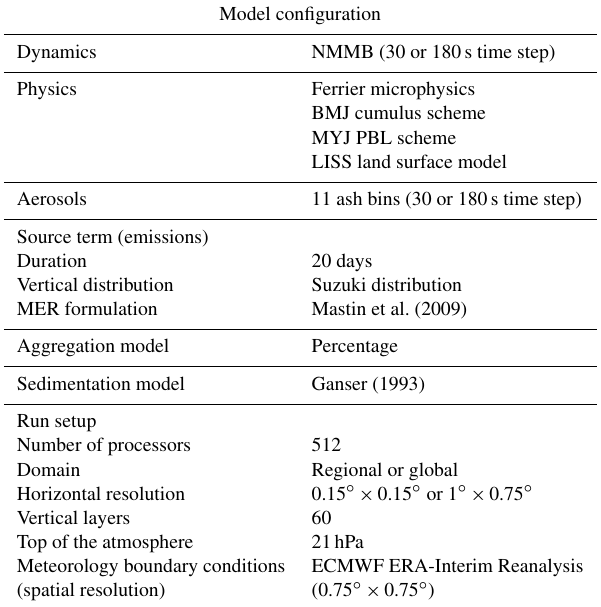
Table 7. Model configuration for the 2011 Cordón Caulle regional and global runs. The regional run used a horizontal resolution of 0.15 ◦ × 0.15 ◦ with a 30s dynamic time step, while the global do- main used a horizontal resolution of 1 ◦ × 0.75 ◦ with a 180s dy- namic time